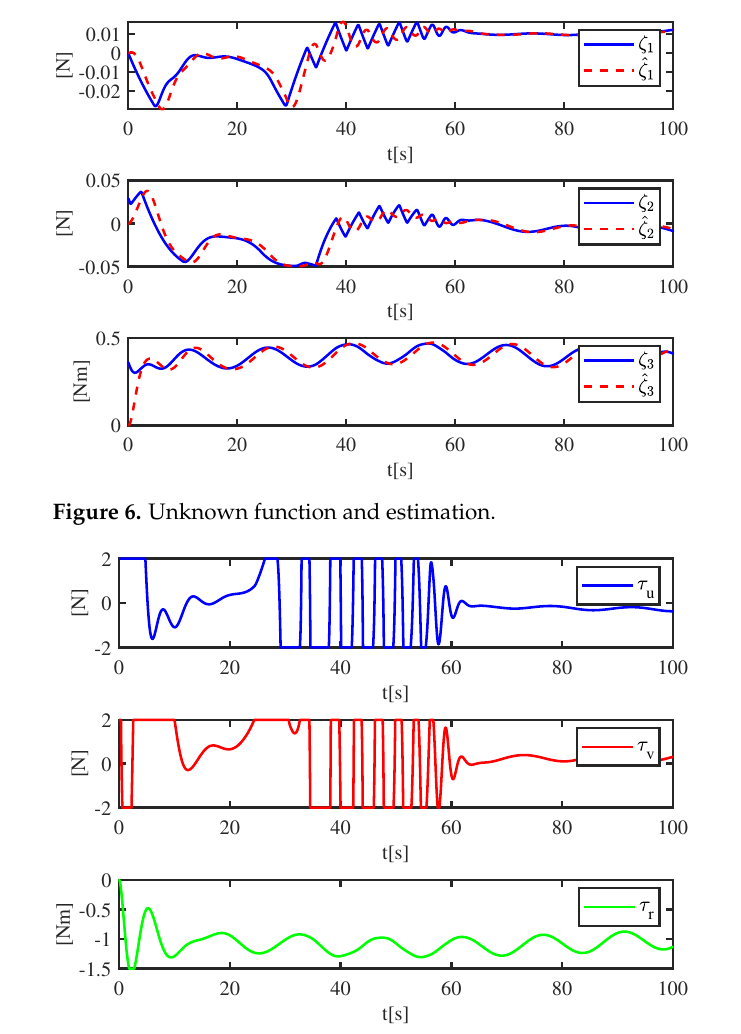
Figure 7. Control